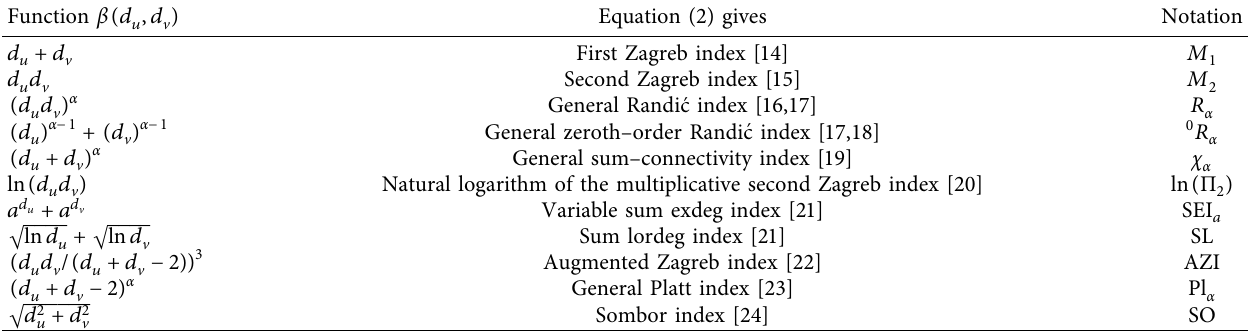
Table 1: Some of the existing bond incident degree